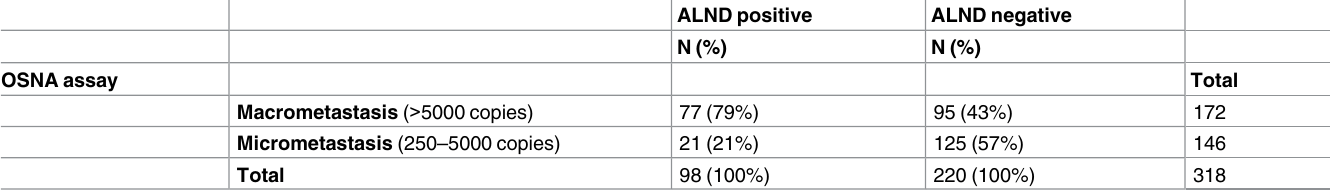
Table 2. Relationship between ALND and SLN status according to traditional cut-off (N =